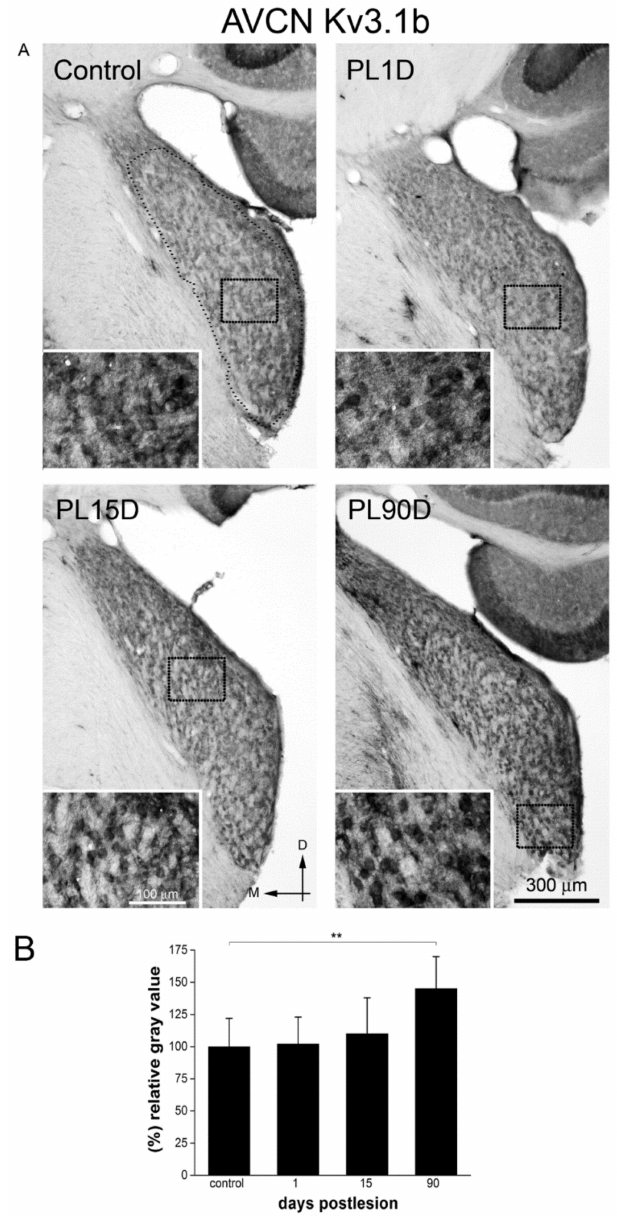
Figure 5. Kv3.1b immunoreactivity levels increase significantly in the AVCN at long-term after cochlear lesion. ( A ) Low-magnification photomicrographs of coronal sections of AVCN. The dotted contour (small dots) in A, outlines an example of the region of interest in the AVCN where thresholding segmentation was carried out for quantification of immunoreactivity. Equivalent regions were selected in all sections sampled. Insets (squares outlined with larger dots in A and B) show high-magnification details of the image. Photographs are representative of five animals. Calibration bars apply to all panels in the figure. ( B ) Quantitative analysis of relative gray values average at each post-lesion time for Kv1.1 in the AVCN. Data are expressed as mean ± S.D. Asterisks show statistically significant di ff erences (** p < 0.01) as determined by one-way ANOVA (F (3,191) = 25.015; p < 0.001), Sche ff e and Tukey post-hoc